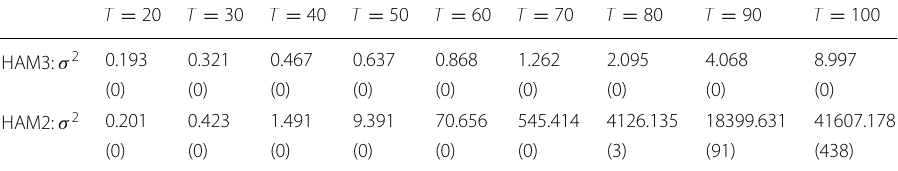
Table 3 Simulation results